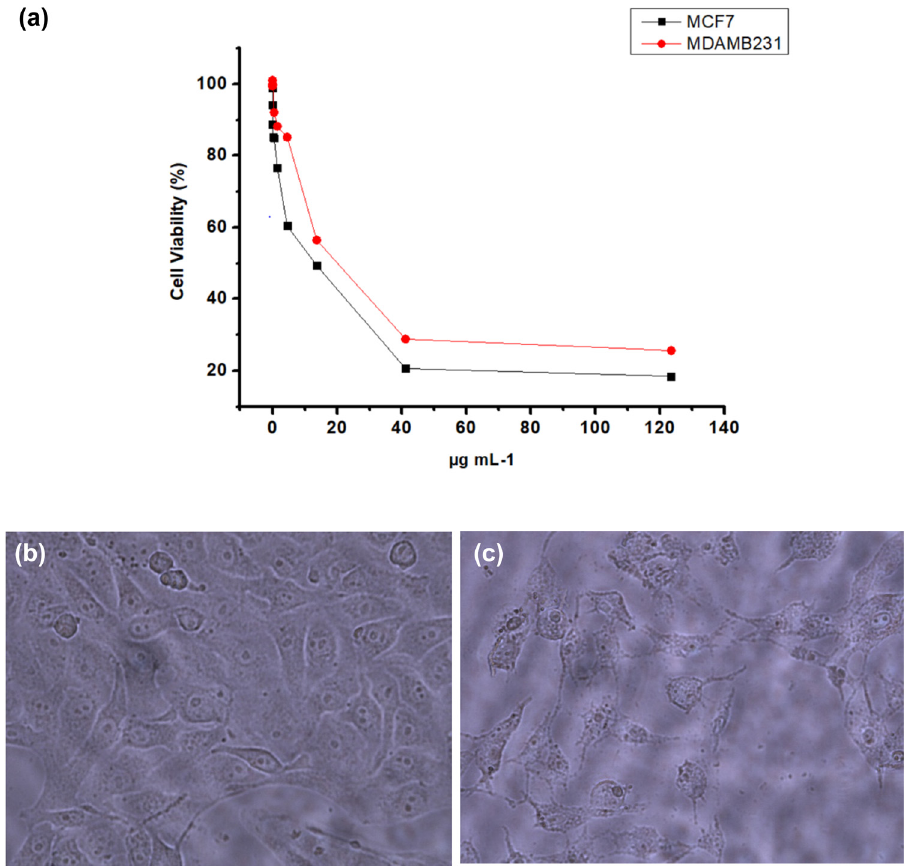
Figure 2: ( a ) Cytotoxic activity of 7b on MCF - 7 and MDA - MB - 231 cells using MTT assay; ( b ) control; and ( c ) cells treated with 7b showing shrinkage and detachment from the surface ( 24 h )